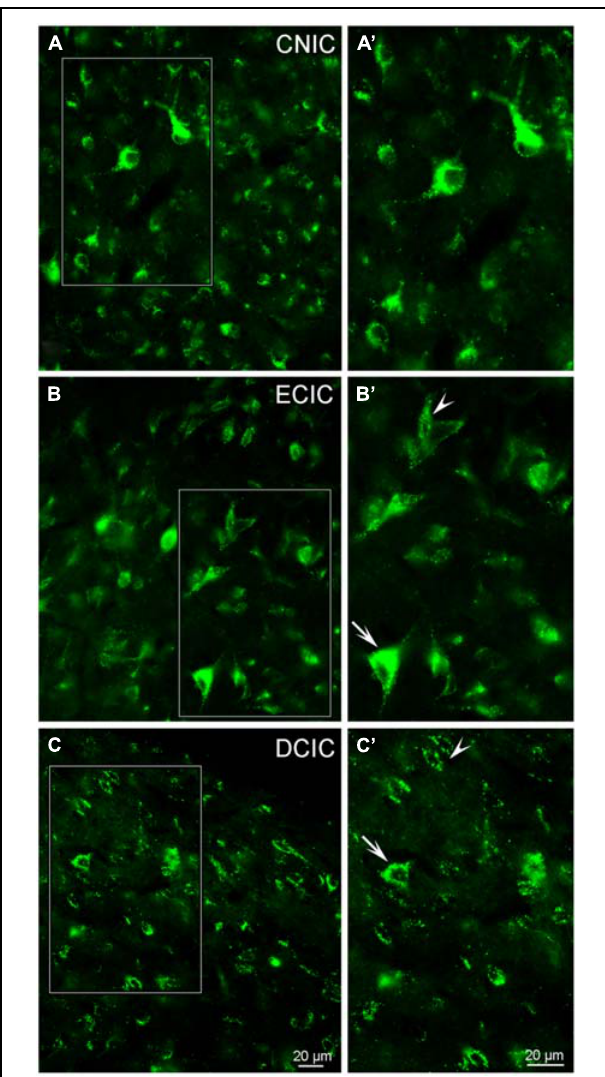
FIGURE 14 | In the IC VGLUT3 is distributed throughouteach subdivision. Although some labeling is observed in terminals, the majority of labeling for VGLUT3 is contained within somata and dendrites (A–C) . In the CNIC large and small multipolar neurons with round somata and proximal dendrites are labeled for VGLUT3 (A,A’) . While prominent somatic labeling for VGLUT3 is found in the ECIC (B,B’) and DCIC (C,C’) localized to small elongated neurons with little to no labeling of proximal dendrites (arrowheads) as well as within larger neurons, including proximal dendrites (arrows). CNIC – central nucleus of the IC; ECIC – external cortex of the IC; DCIC – dorsal cortex of the IC; Scale bars: 20 μ m.